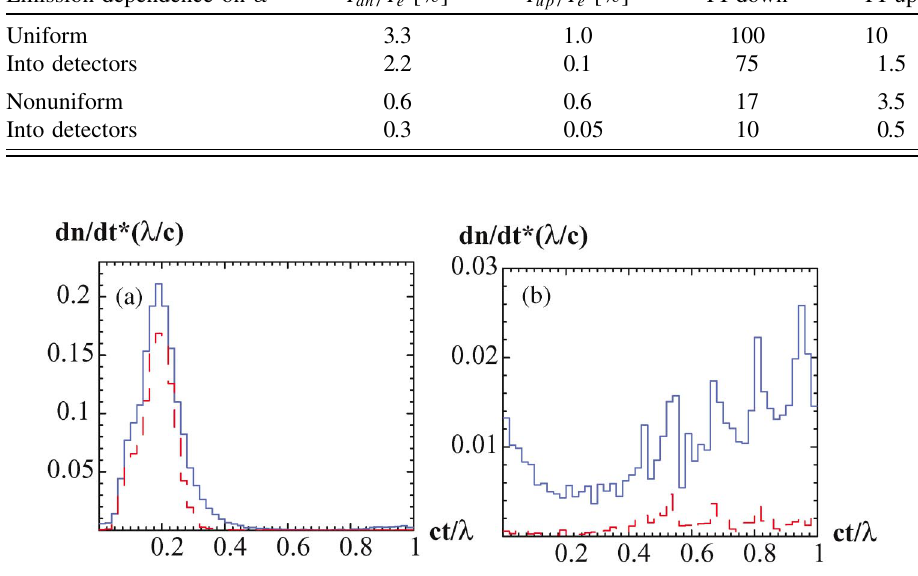
FIG. 7. (Color) For emission uniform with (cid:17) : time distribution of dark current exiting the structure (solid) and entering the detectors (dashes), at the downstream (a) and upstream (b) ends.